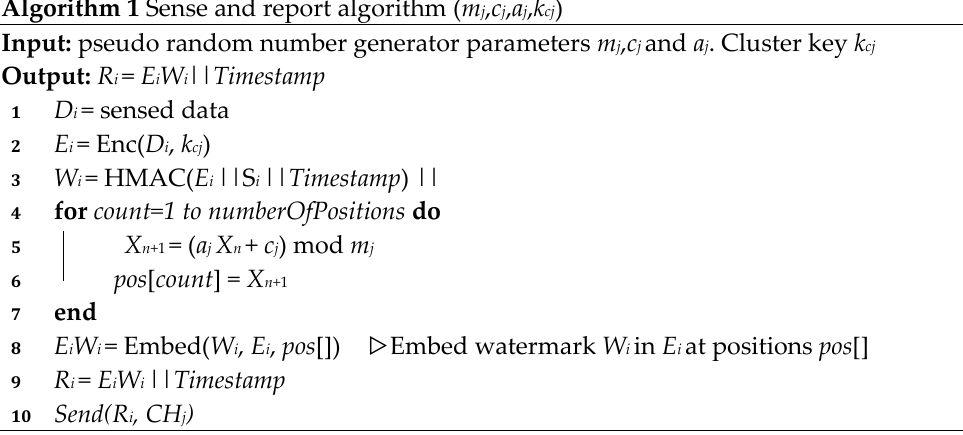
Algorithm 1. The pseudocode for the sensing and reporting phase. Algorithm 1 Sense and report algorithm ( m j , c j , a j , k cj